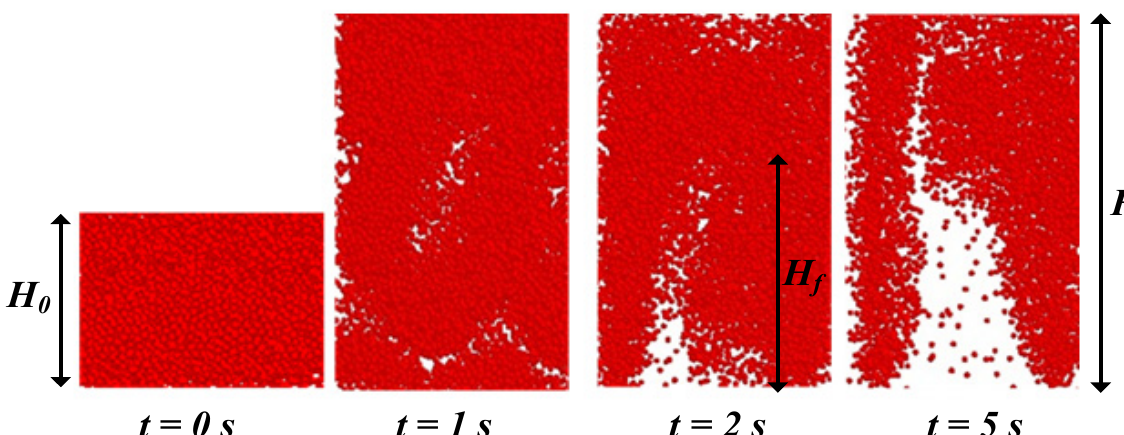
Figure 6. Transitional phases of destabilization by homogeneous fluidization of an initially loose sand stack.